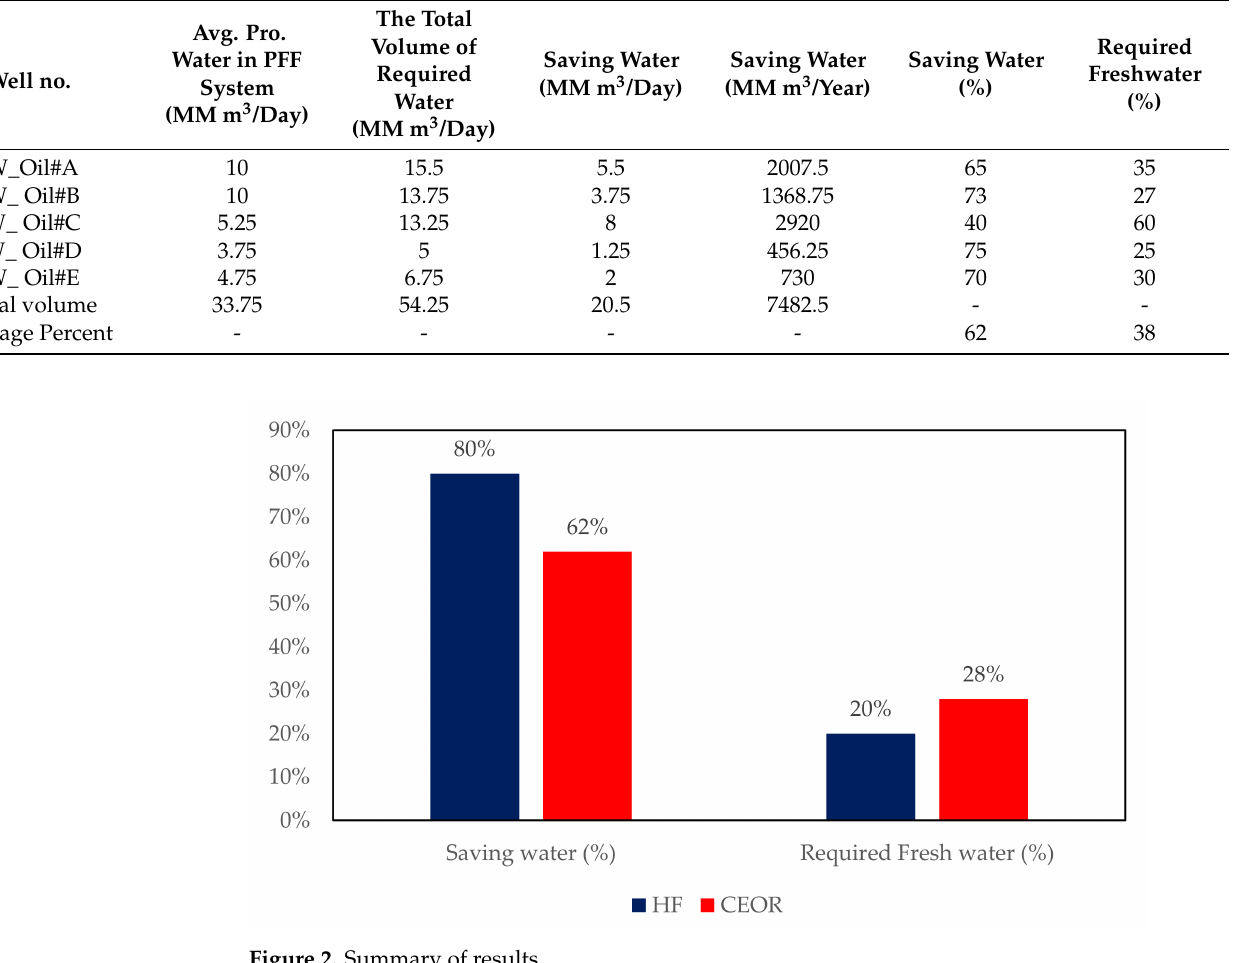
Figure 2. Summary of